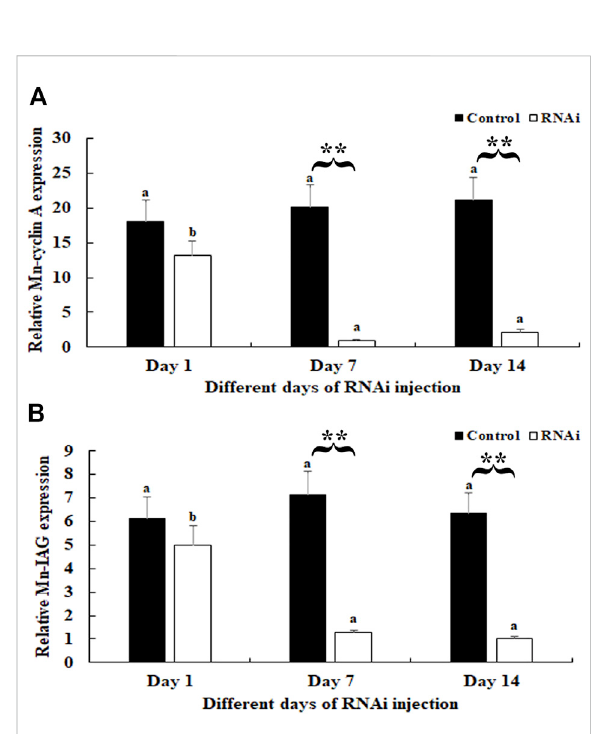
FIGURE 4 Measurement of Mn - CycA and Mn-IAG expression at different days after dsCycA and dsGFP injection. The amount of Mn-CycA and Mn-IAG mRNA was normalized to the EIF transcript level. Data are shown as mean ± SD (standard deviation) of tissues from three separate individuals. Lowercases indicated expression difference between different days after dsGFP and dsCycA injection. ** ( p < 0.01) indicates signi fi cant expression difference between the dsCycA and dsGFP treated prawns at the sample day. (A) Measurement of Mn-CycA expressionatdifferentdaysafter dsGFP and dsCycA injection. (B) Measurementof Mn-IAG expressionatdifferentdaysafter dsGFP and dsCycA